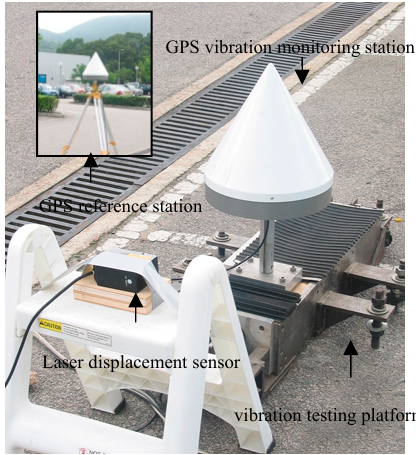
Figure3. Setup of GPS simulation shaking experiment system. Figure 3. Setup of GPS simulation shaking experiment